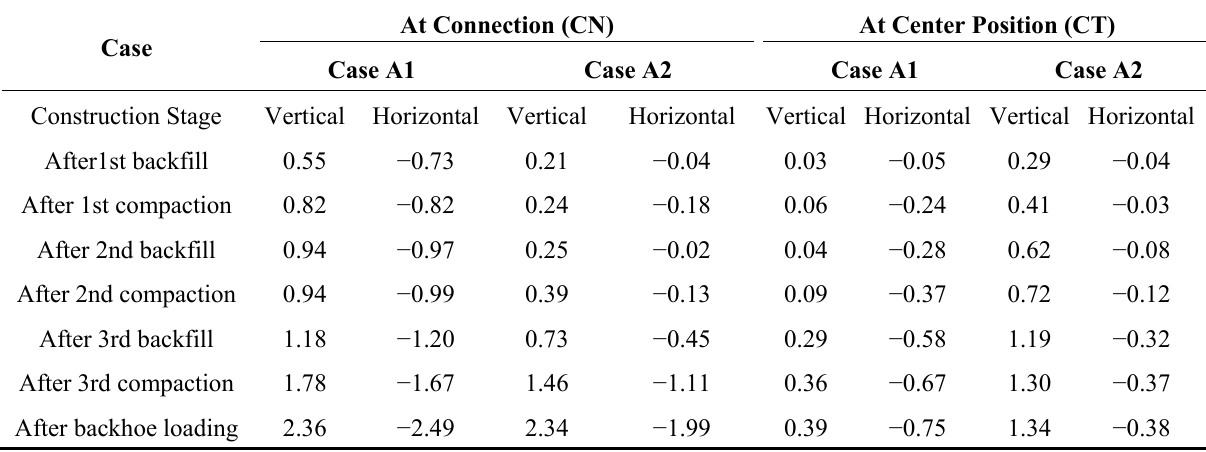
Figure 5. The displacement of each case with construction stages. ( a ) Case A1 ; ( b ) Case A2 . Table 5. Pipe Deformation at the Connection (CN) and the Center Position